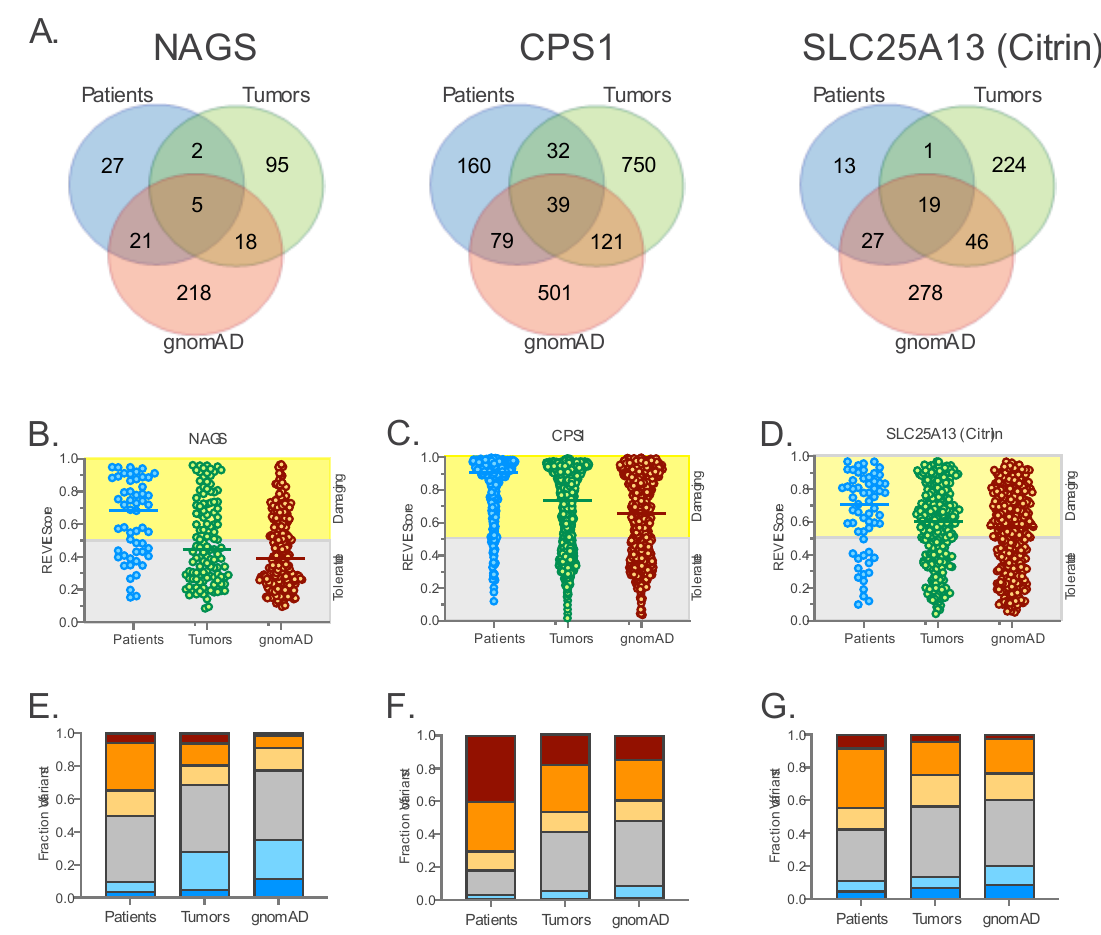
Figure 6. NAGS , CPS1 , and citrin missense variants in urea cycle patients, tumors, and individuals without rare genetic disorders. ( A ) Venn diagrams showing overlap between NAGS , CPS1, or citrin missense variants found in patients with respective deficiencies, tumors, and gnomAD. ( B – D ) REVEL scores of NAGS ( B ), CPS1 ( C ) and citrin ( D ) missense variants found in patients (blue), tumors (green), and gnomAD (orange). Yellow–REVEL scores that indicate damaging effect of missense variants on protein function; gray–REVEL scores indicating that missense variants are tolerated and do not affect protein function. ( E – G ) Fraction of sequence variants with REVEL scores indicating strength of evidence for either damaging or benign effect of missense variant on NAGS ( E ), CPS1 ( F ) and citrin ( G ) function in patients with respective deficiencies, tumor samples, and gnomAD. Brown–strong evidence for damaging effect on protein function; orange–moderate evidence for damaging effect on protein function; light orange–supporting evidence for damaging effect on protein function; gray–uncertain effect on protein function; light blue–supporting evidence for benign effect on protein function; dark blue–moderate evidence for benign effect on protein function.